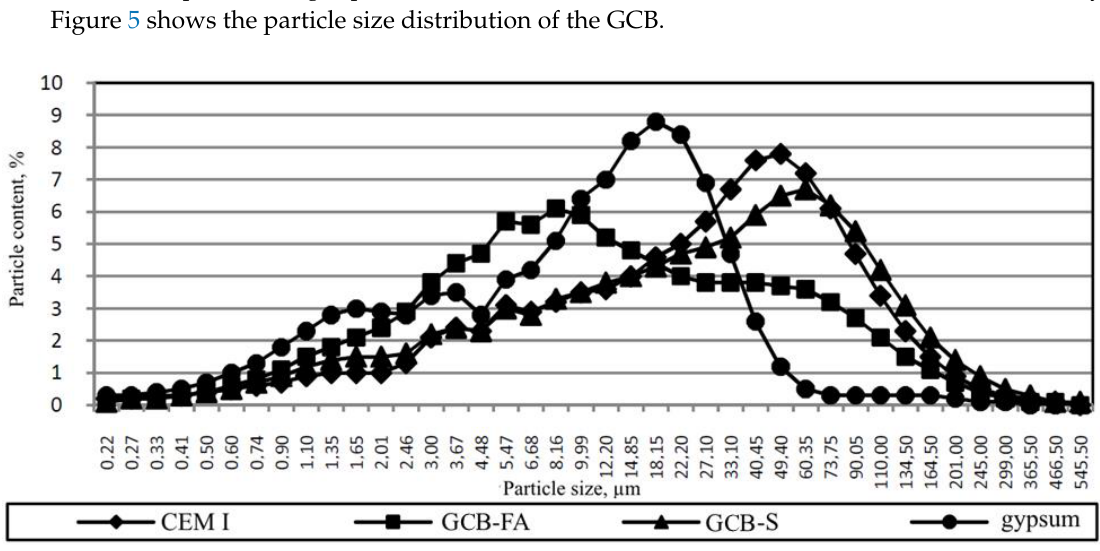
Table 7. The composition of the hydration products of the gypsum-cement binder- fly ash (GCB-FA) at microprobe points.